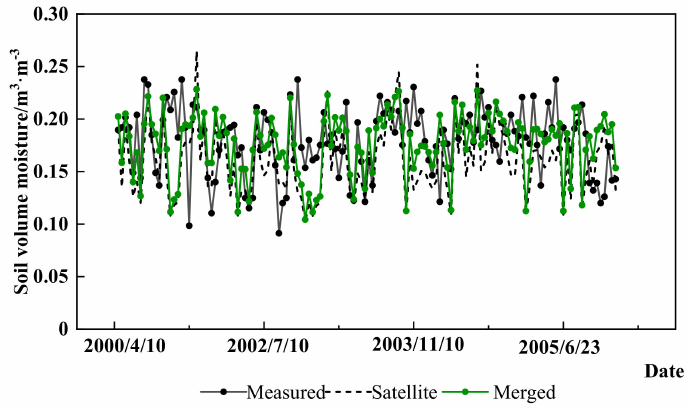
Figure 4. Time series curve of the soil moisture before and after adjustment.